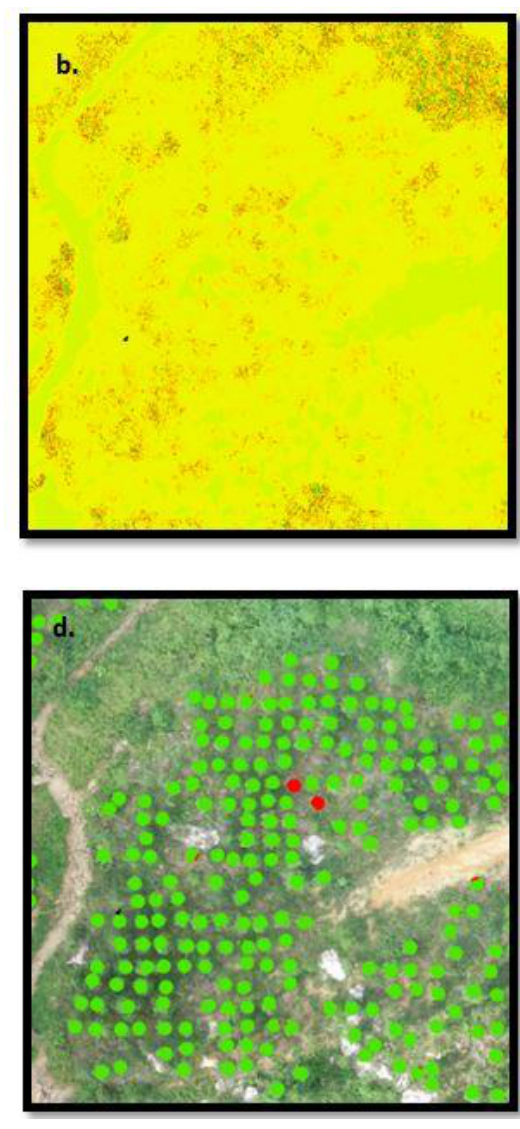
Figure 7. VARI-green image overlay with ortho-mosaic images showing the result of VARI-green from the raw data result to the normalized data result. ( a ) Ortho-mosaic Image Raster. ( b ) VARI-green raster. ( c ) Clipped Normalised VARI-green raster. ( d ) Normalised VARI-green raster